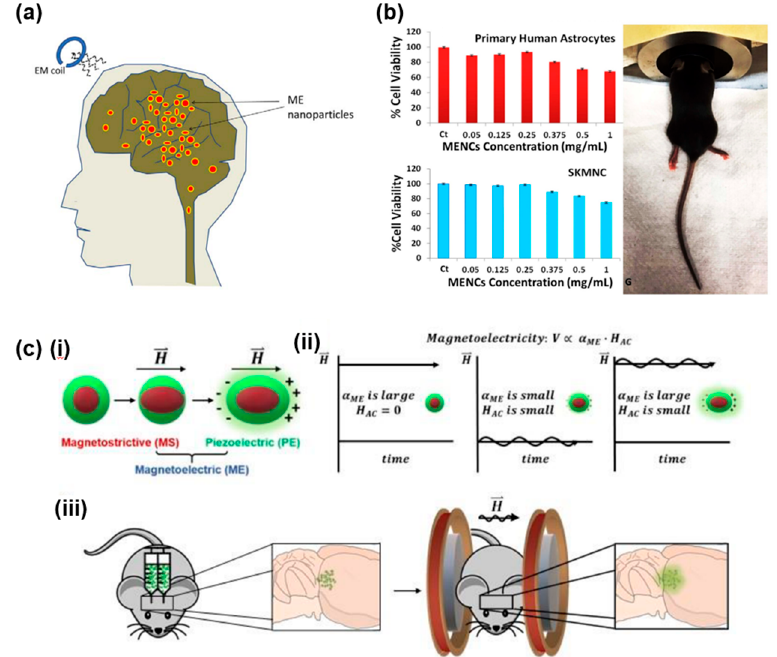
Figure 7. Brain stimulation utilizing the electric field generated from MENPs under the application of the magnetic field. ( a ) Illustration of human brain stimulation using MENPs. Reproduced with permission from [49]. Copyright 2012, PLoS ONE. ( b ) In vivo study on mice showing successful brain stimulation using MENPs. Reproduced with permission from [97]. Copyright 2016, Nature. ( c )-(i) ME effect generated using MENPs, (ii) external application of combined AC and DC magnetic fields, (iii) in vivo wireless deep brain stimulation. Reproduced with permission from [80]. Copyright 2021, Science.